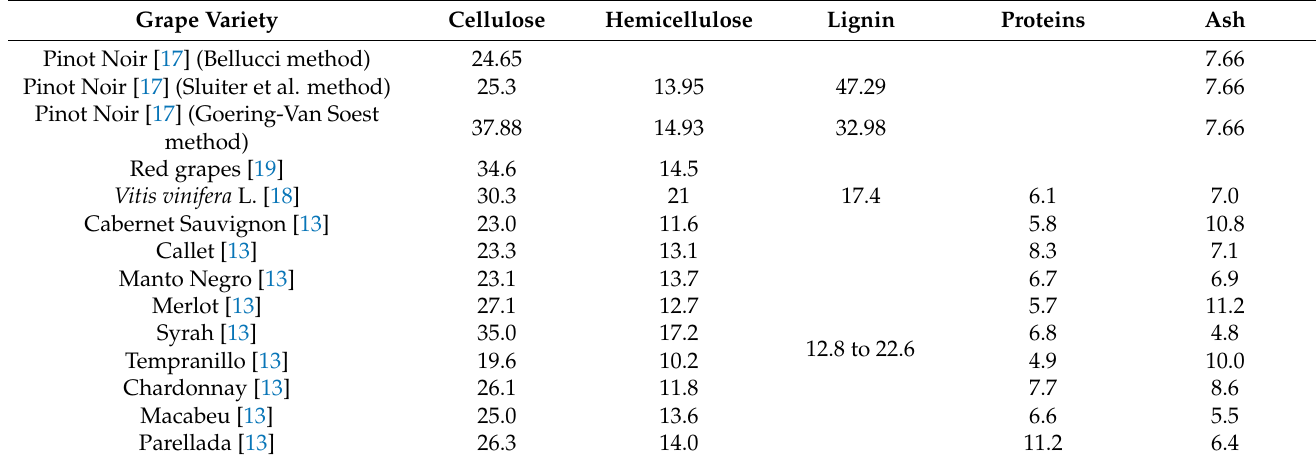
Table 1. Main chemical components of stems (values expressed in %